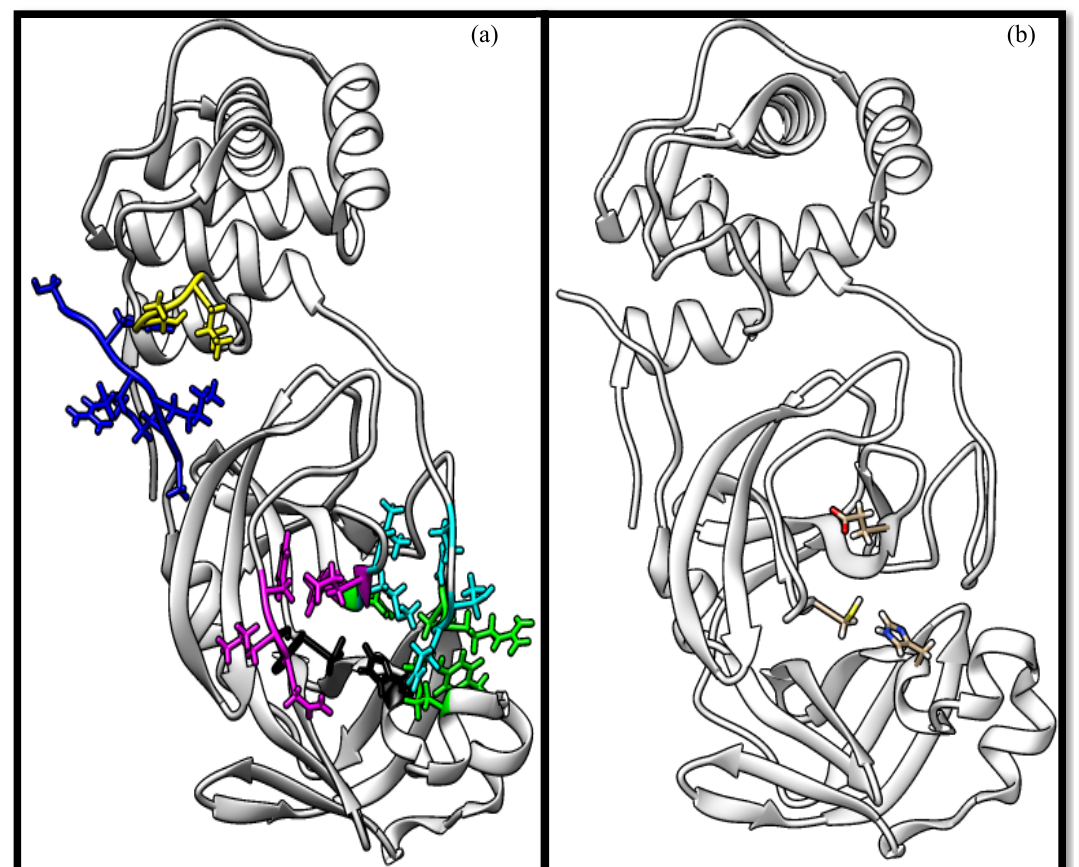
Figure 1. The crystal structure of chymotrypsin-like protease of SARS-CoV-2 (PDB ID: 6Y2E) and its active residues. ( a ) Color indicates the residues involved in the formation of the S1 site (shown in magenta), S1 site from the other promotor (blue), S2 site (green), S4 site (cyan), and S1’ site (black), in addition to SER 284, ALA 285, and LEU 286 (yellow). ( b ) Only the catalytic dyad and GLU 166 residues.